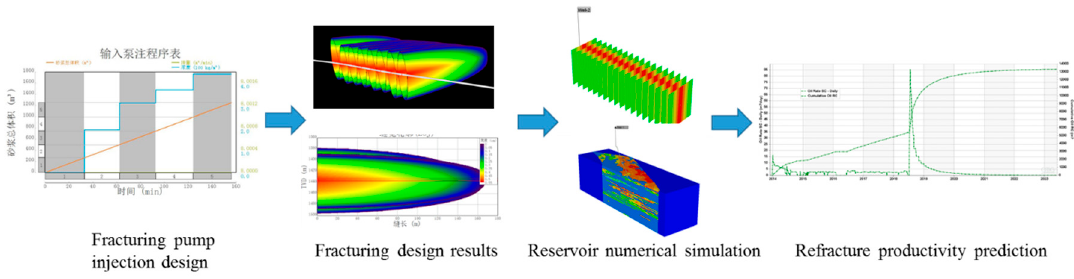
Figure 1. Reservoir numerical simulation model partial permeability image and its distribution.